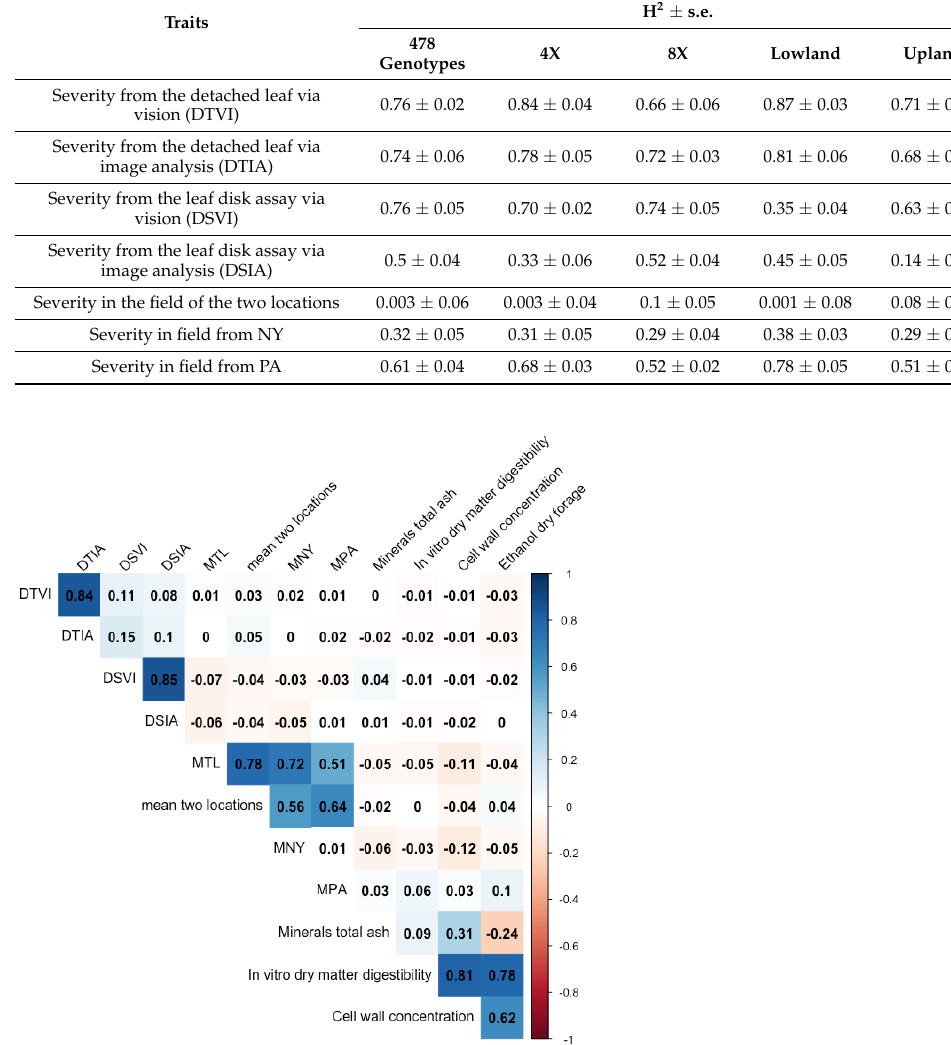
Table 1. Broad-sense heritability of each trait in each group.